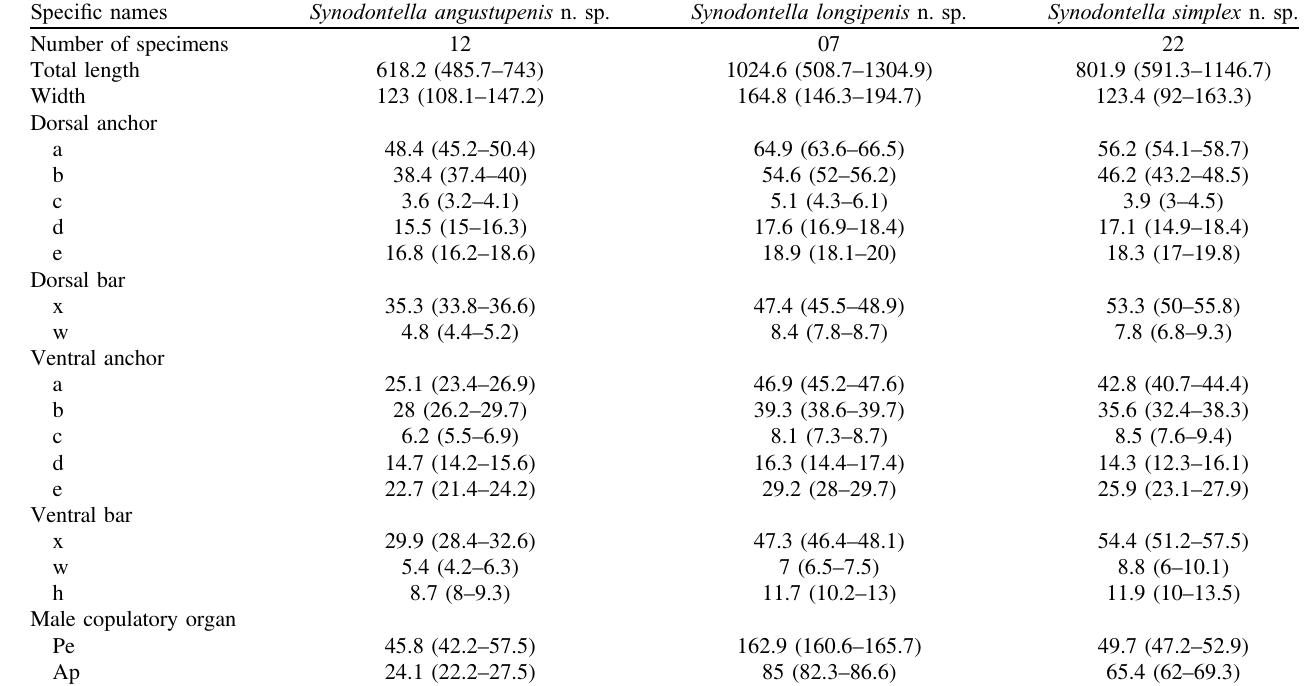
Table 1. Measurements of the three new species (in l m: mean (minimum-maximum)). Specific